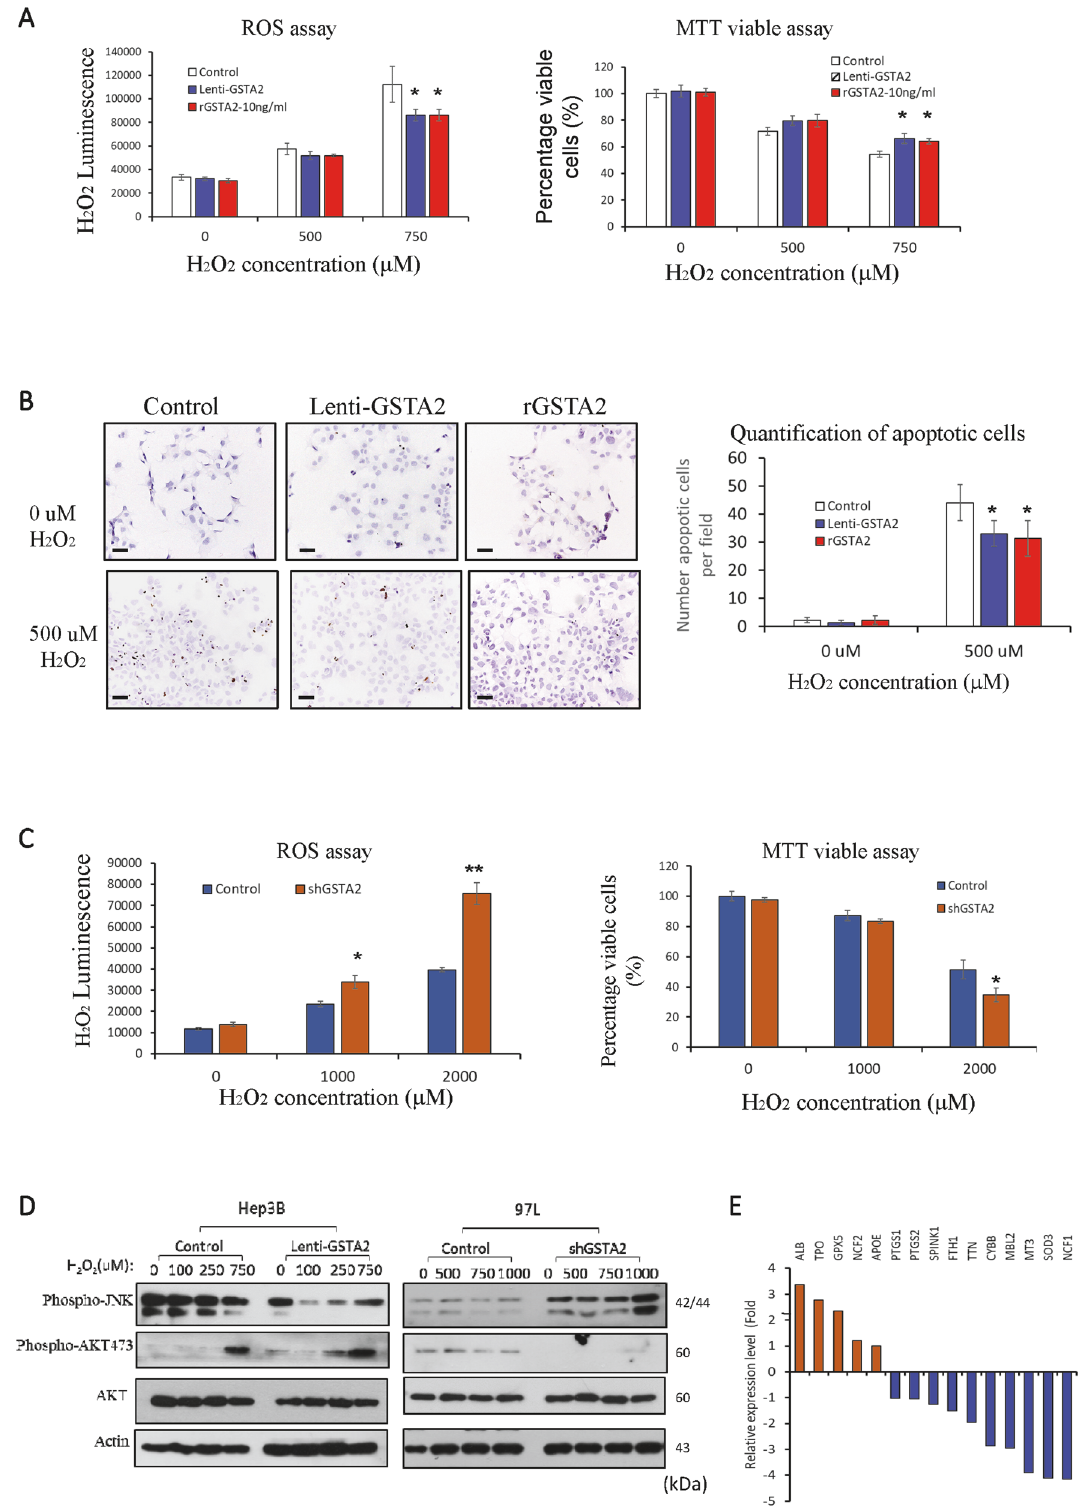
Fig. 3 The mechanism of GSTA2 in regulating ROS embolism of HCC. A ROS assay and MTT assay of Hep3B cells with upregulated expression of GSTA2 (Lenti-GSTA2) or administration of human recombinant GSTA2 protein (rGSTA2) under different concentrations of H 2 O 2 . B TUNEL apoptosis assay of Hep3B cells with upregulated expression of GSTA2 (Lenti-GSTA2) or administration of human recombinant GSTA2 protein (rGSTA2) under H 2 O 2 condition. Scale bar: 100 μ M. C ROS assay and MTT assay for 97L-Control and 97L-shGSTA2 cells under different concentrations of H 2 O 2 . D Western blot analysis of JNK and AKT pathway in GSTA2-overexpressing and GSTA2-suppressing HCC cells under H 2 O 2 conditions. E Differentially expressed ROS-associated genes by RT 2 PCR array analysis in MHCC97L-shGSTA2 cells and MHCC97L-control cells under H 2 O 2 condition. * P < 0.05; ** P <